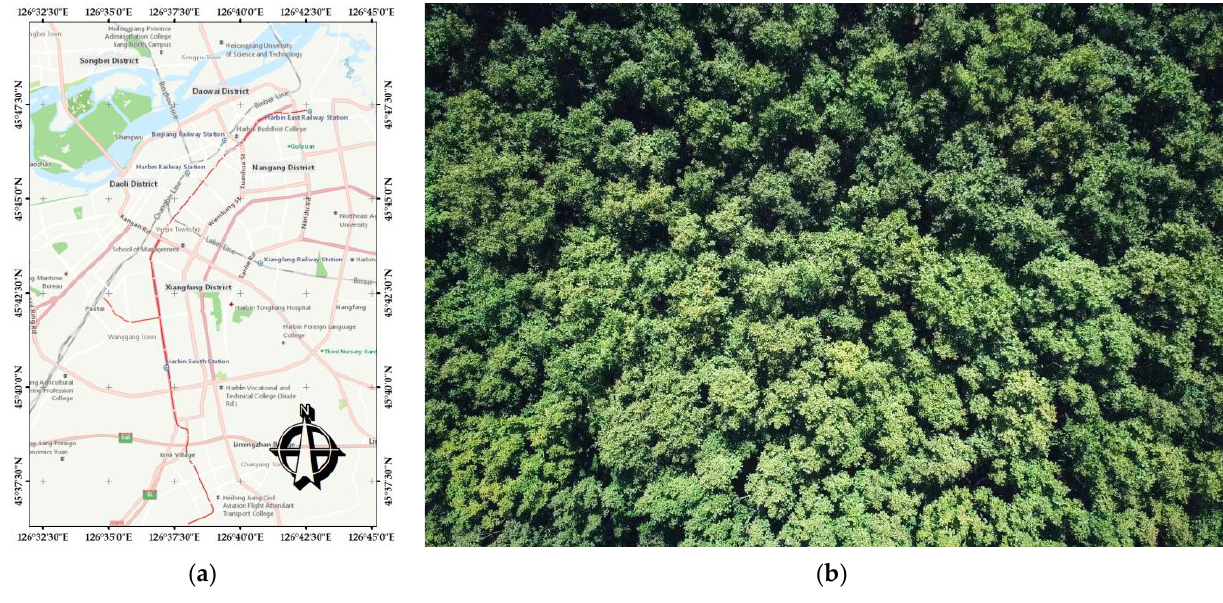
Figure 1. ( a )The location map of the study area; ( b ) aerial view of the study area. Table 1. ULS parameter settings.